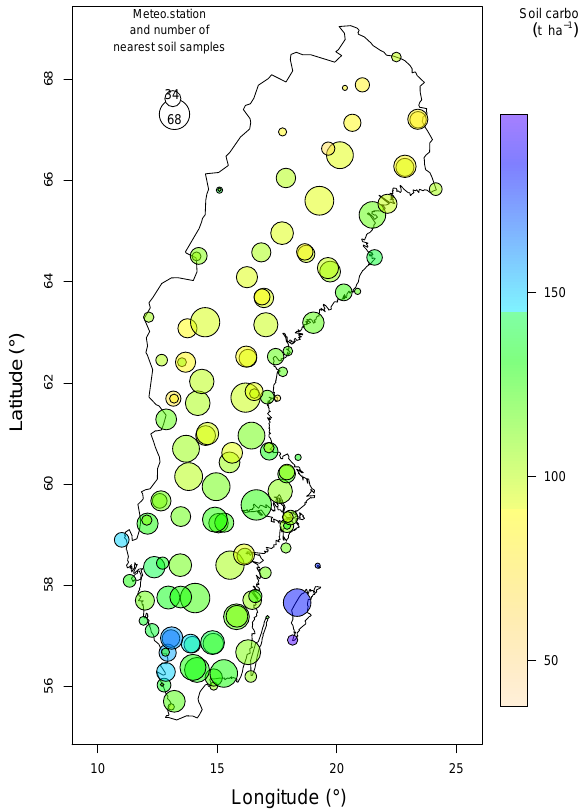
Figure 1. Geographical locations of meteorological stations with corresponding number of nearest soil samples ( n , size of the circle) and their mean measured soil organic carbon stock (tCha − 1 , color of the circle) across